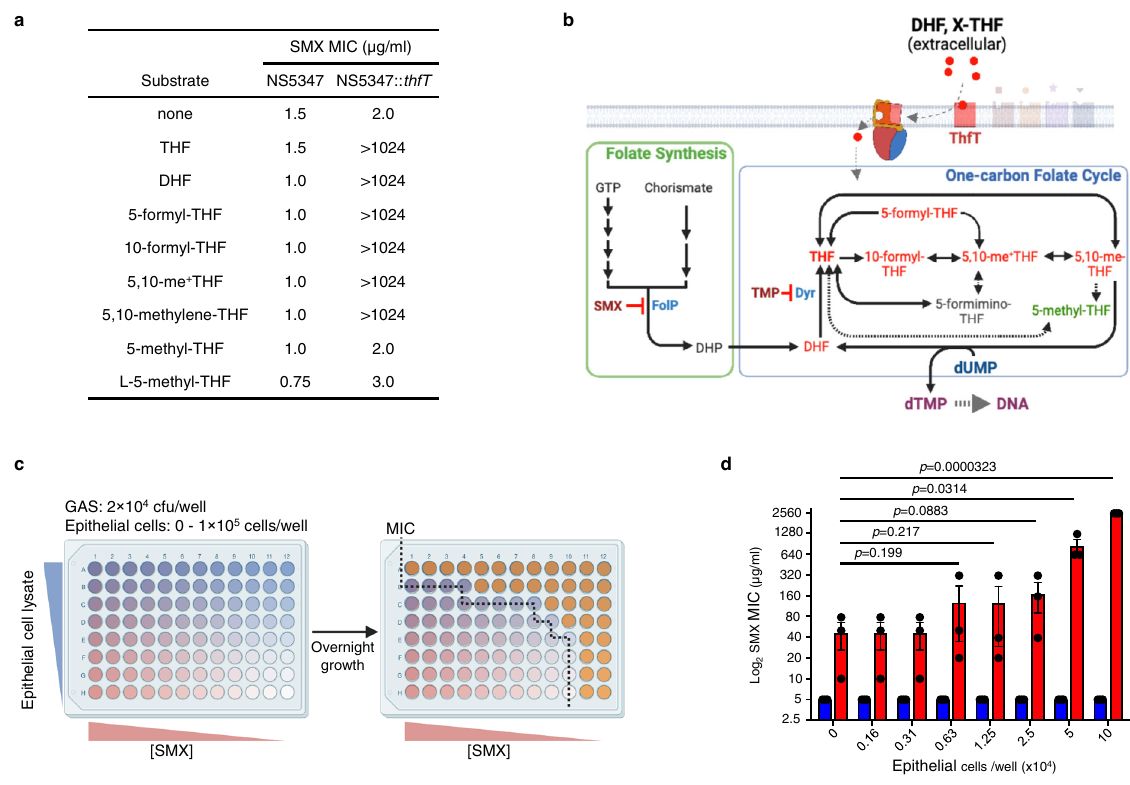
Fig. 5 | ThfT enables SMX-resistance by uptake of multiple one-carbon folate cycleintermediatesfromhostcells.a AbilityofNS5347encoding thfT variantsto utilise multipleonecarbon THFintermediate compounds.SMX MICs ( μ g/ml) were determined by Etest in the presence of 50ng/cm 2 of each compound on MHF-Bm agar. Results are median values from three independent experiments. Statistical analysis of groups is in Supplementary Table 7. 5,10-me + THF, 5,10-methenyl-THF. b Model of ThfT mediated SMX resistance in the presence of one-carbon folate cycle intermediate compounds. Compounds utilised by ThfT to bypass the inhi- bitory action of SMX are highlighted in red and compounds which could not be utilised byThfTarehighlighted ingreen.5-formimino-THF(grey)wasnotavailable for testing. Solid black arrows indicate pathways that are likely functional in GAS based on the presence of predicted enzymes in the core GAS genome, while pathwaysindicatedwithdashedgreyarrowsindicatetheabsenceofcorresponding